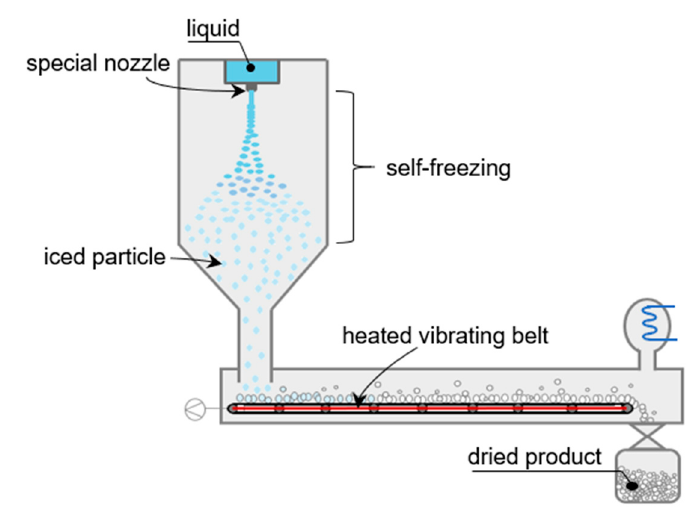
Figure 5. Schematic design of the fine-spray freeze-drying system.